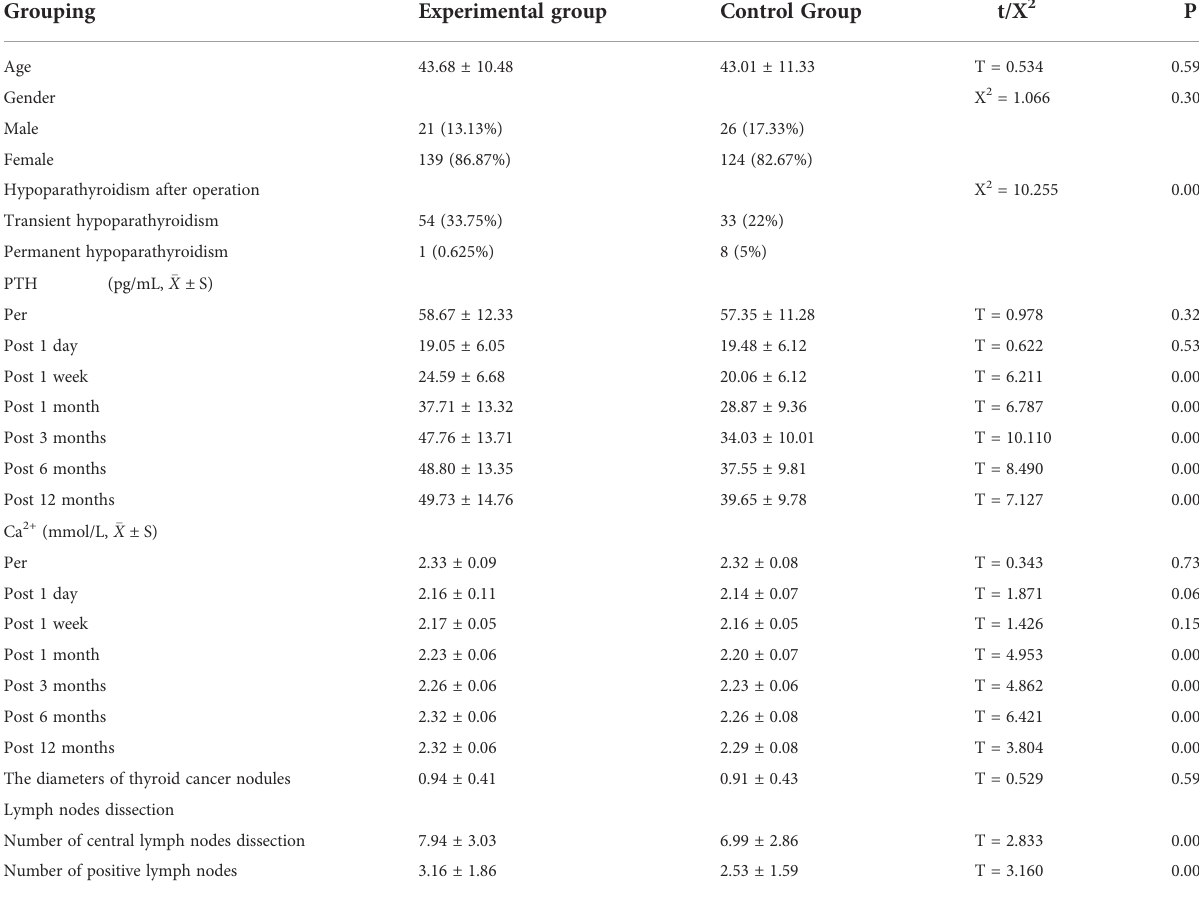
TABLE 1 General data, surgical biochemical data and postoperative pathology of patients. Grouping Experimental